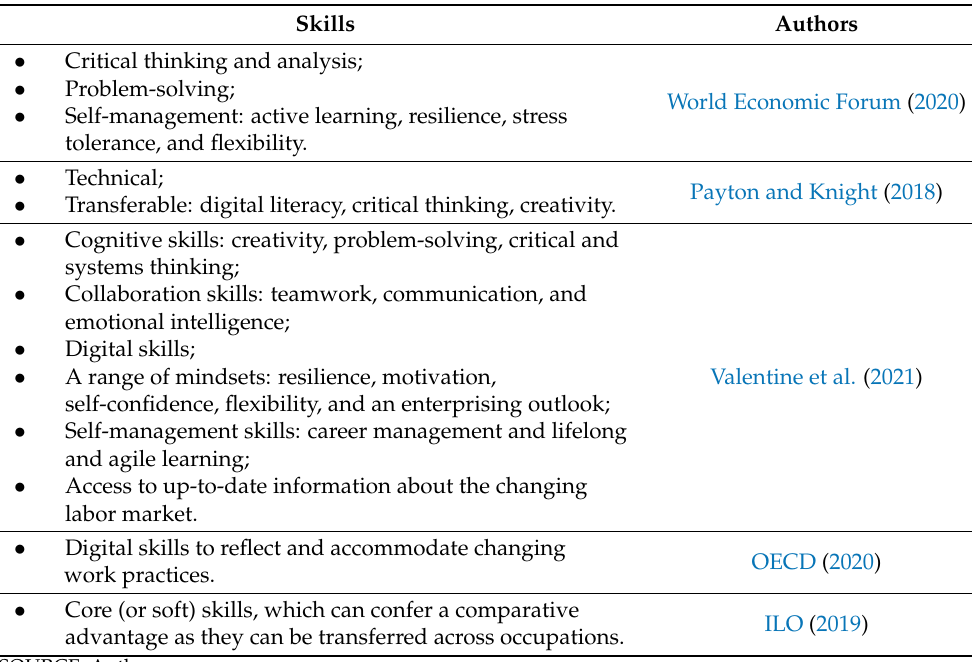
Table 1. Skills of future